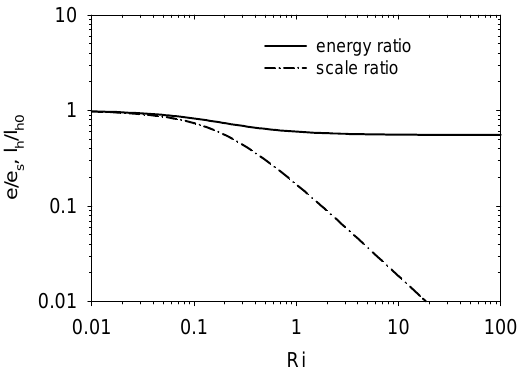
Fig. A6. Normalized subgrid-scale energy e and mixing length- scale for heat ‘ h versus Richardson number, e s = e(Ri = 0 ) , ‘ h 0 = ‘ h (Ri = 0 ) .